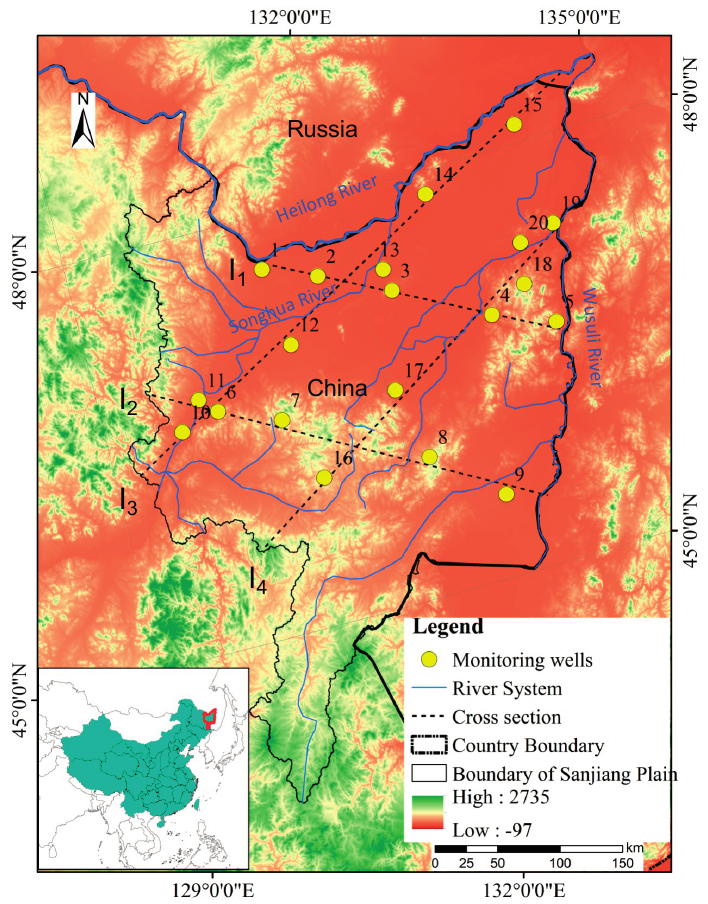
Figure 1. Geographical locations of the Sanjiang Plain, Northeast China and the 20 monitoring wells used in this